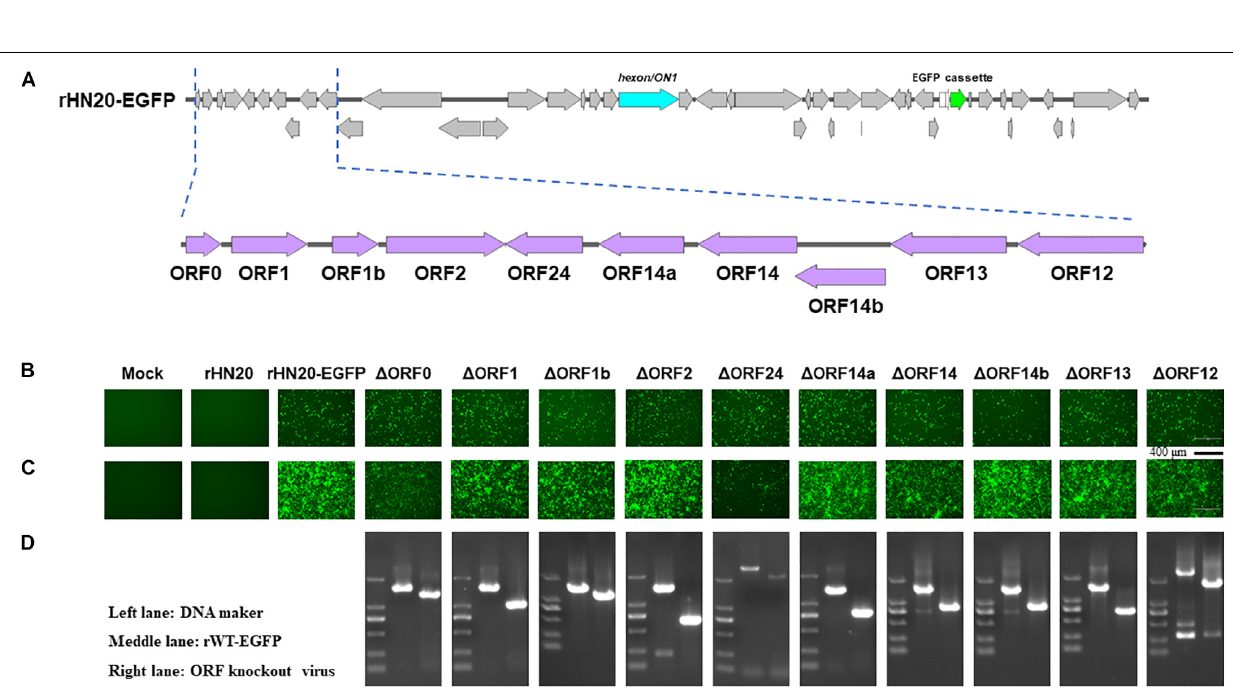
FIGURE 2 | Identification of non-essential open reading frames (ORFs) in the left of the FAdV-4 genome. (A) Diagram of the genomic structure of rHN20-EGFP. Focal amplifications in purple represent ORFs unique to fowl adenoviruses on the left. (B) Green fluorescence in LMH cells transfected with linearized ORF knockout recombinant fosmids at 48 h post-transfection. Scale bar, 200 µ m. (C) Green fluorescence in LMH cells infected with ORF knockout recombinant viruses at 72 h post-infection. Scale bar, 200 µ m. (D) PCR identification of ORF knockout recombinant virus. A fragment of each recombinant virus containing the knockout ORF was amplified, and rWT-EGFP was used as a